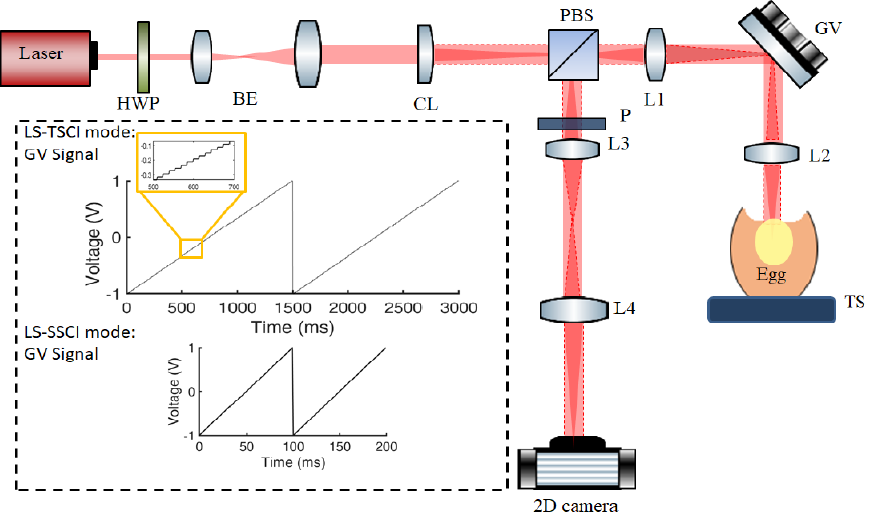
Figure 1. Schematic of the experimental setup for laser speckle imaging: HWP, half-wave plate; BE, beam expander (3×); CL, cylindrical lens; PBS, polarizing beam splitter; GV, 1-D galvo mirror; P, polarizer. TS, translational stage. The focal lengths of CL, L1, L2, L3, and L4 were 50, 50, 75, 40, and 100 mm, respectively.